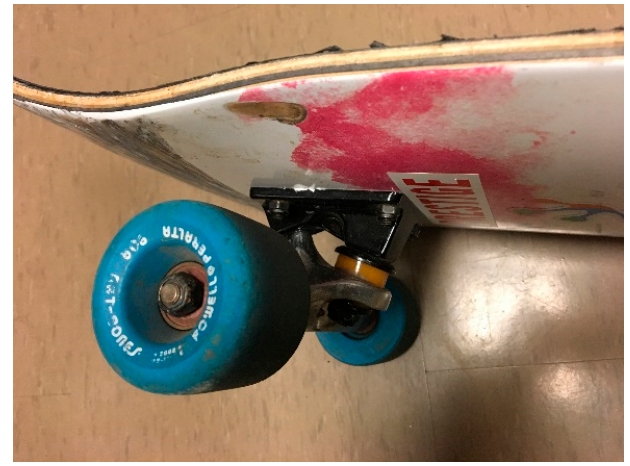
Figure 2. Skateboard Bottom View.